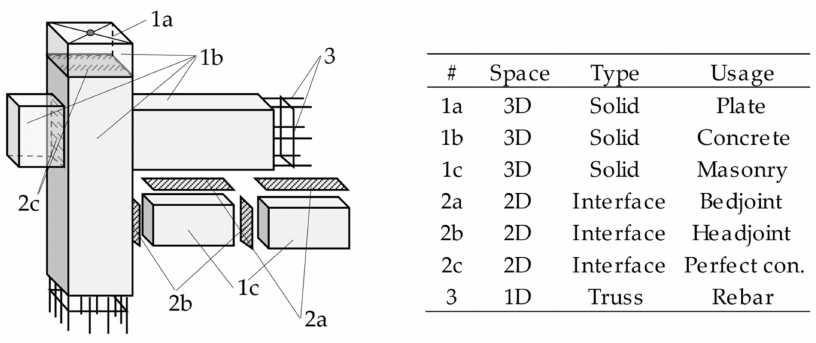
Figure 3. Parts of the